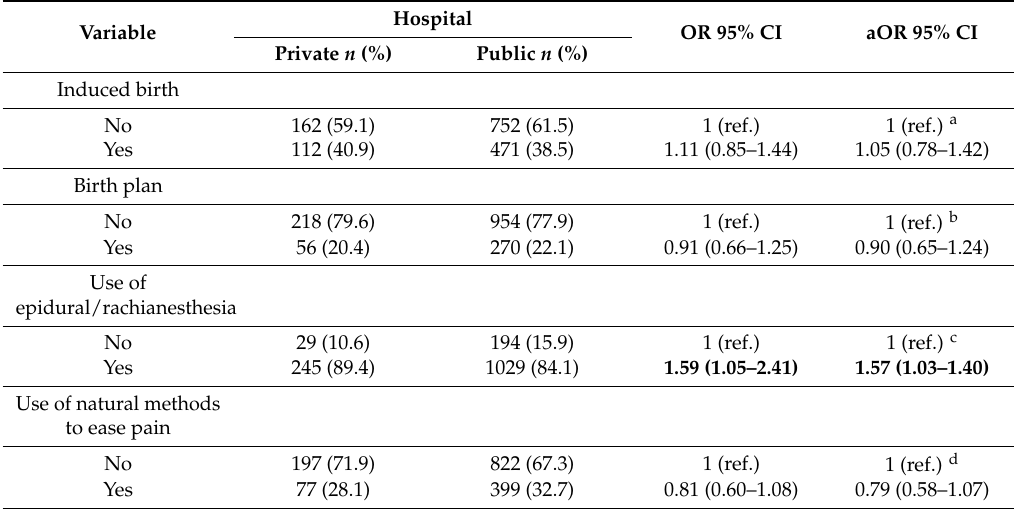
Table 2. Association between the type of hospital (public or private) where delivery occurs and the probability of some clinical practices in primiparous